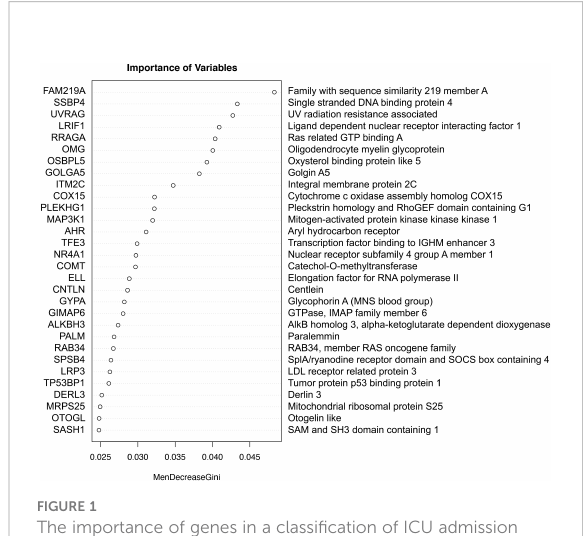
FIGURE 2 ROC analysis of the overall performance of the TopMD-de fi ned gene signature predictive of ICU admission. ROC curve with split 62/38, using top 10 pathways with top 10 genes for a total of 79 genes